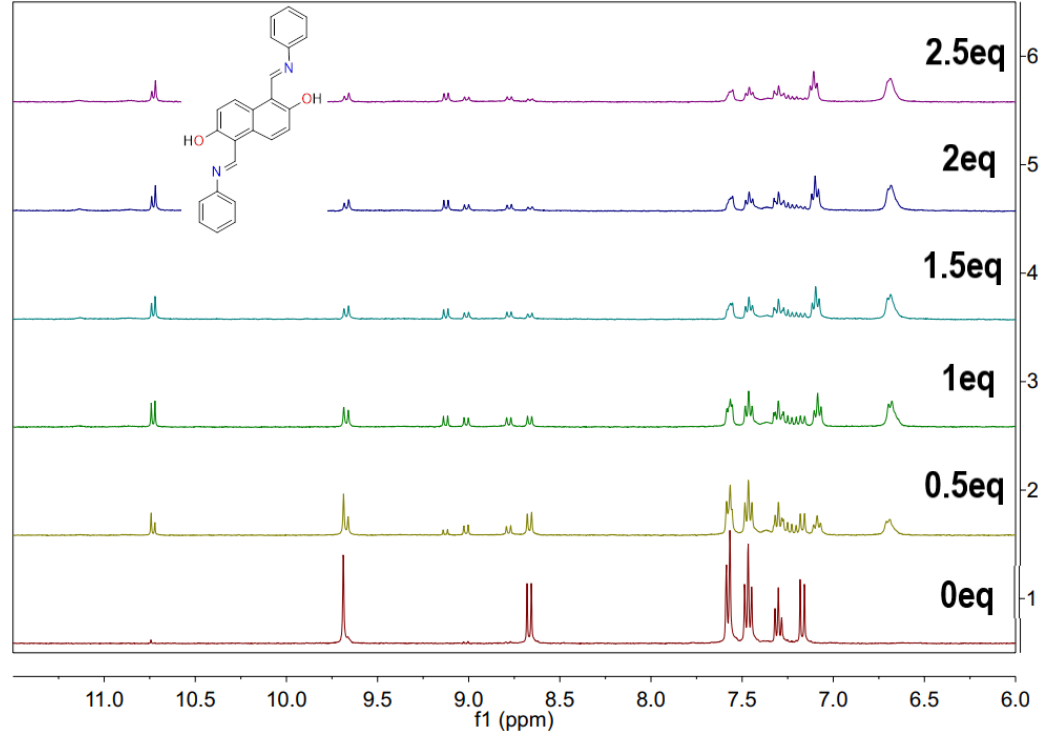
Figure 7. 1 H-NMR spectroscopic titration spectra of L- Cu 2+ on increasing concentrations of Cu 2+ in d-DMSO/D 2 O solution.